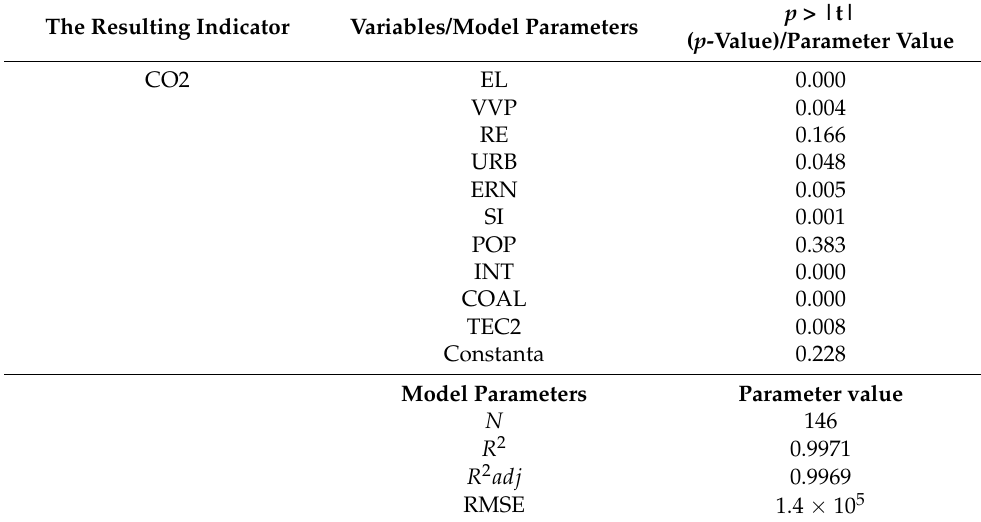
Table 3. List of factors used.